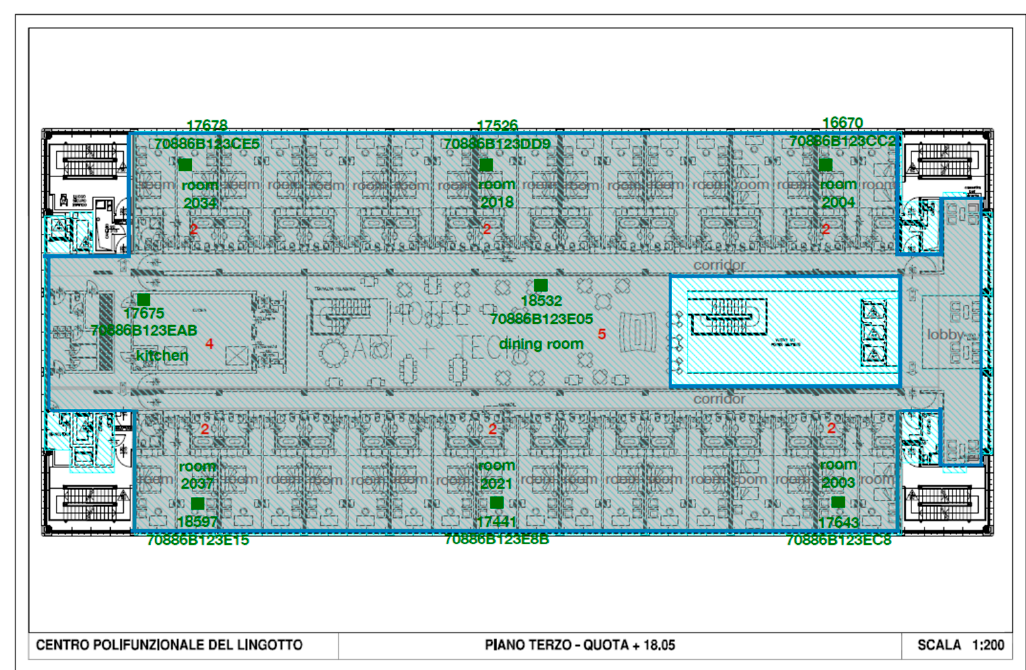
Figure 3. Floorplan of the rooms and restaurant area, third floor, with indication about the placing of the monitoring platform.